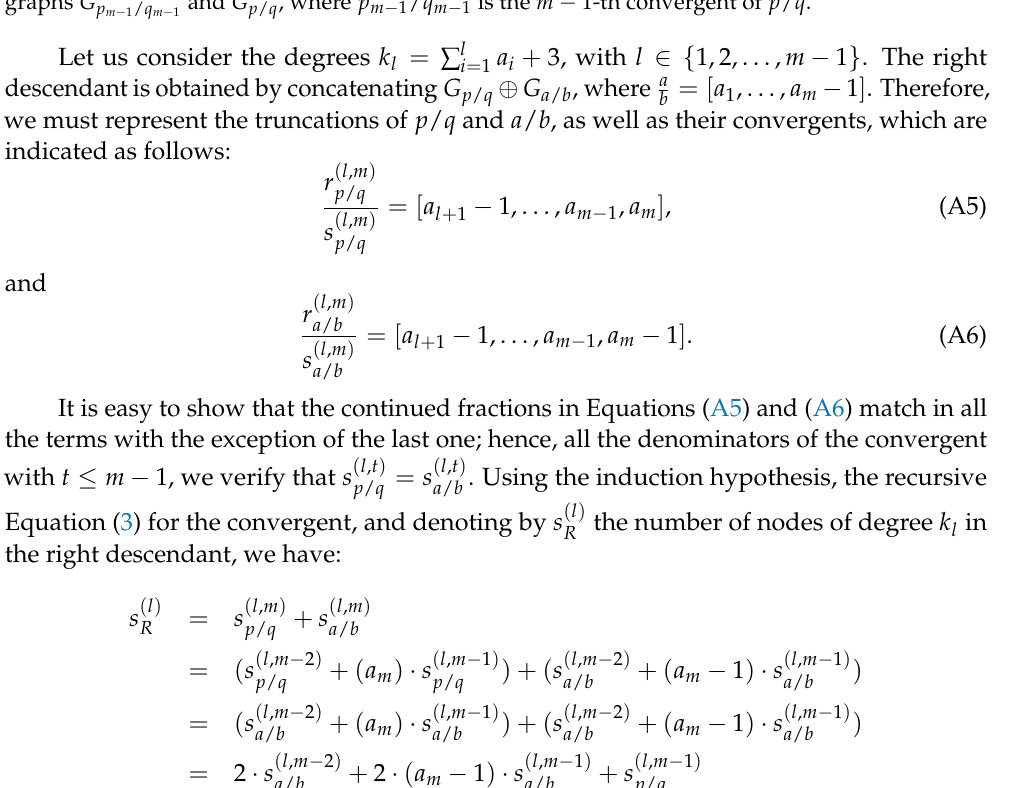
Figure A3. Diagram of the construction for the right descendant of G p / q , where p / q = [ a 1 , . . . , a m ] . The right descendant is expressed as [ a 1 , . . . , a m + 1 ] and is obtained by concatenating the Haros and G p / q , where p m − 1 / q m − 1 is the m − 1-th convergent of p / q graphs G p m − 1 / q m − 1